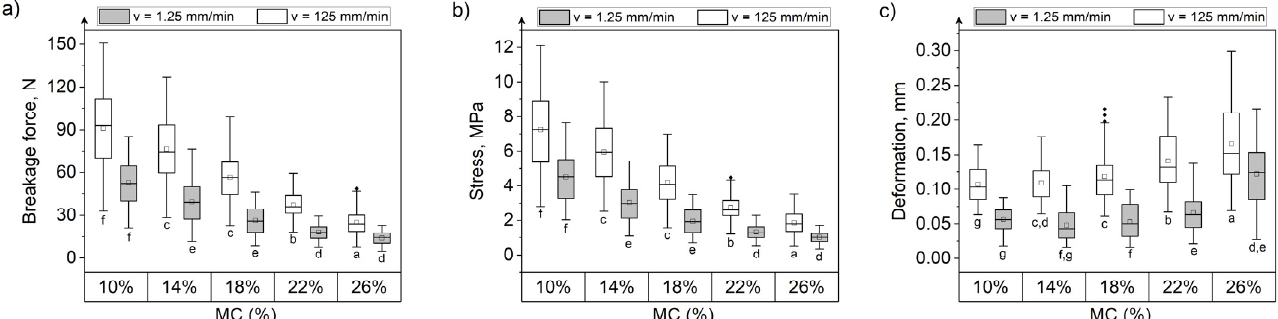
Figure 10. The breakage force ( a ), stress ( b ), and deformation ( c ) during rice grain compression for five levels of moisture content and two loading rates. Letters below the box charts are the interaction grouping letters from the post hoc Fisher least significant difference means comparison test. Means that do not share a letter are significantly different. □— mean, ── — median, ◆ — outliers.